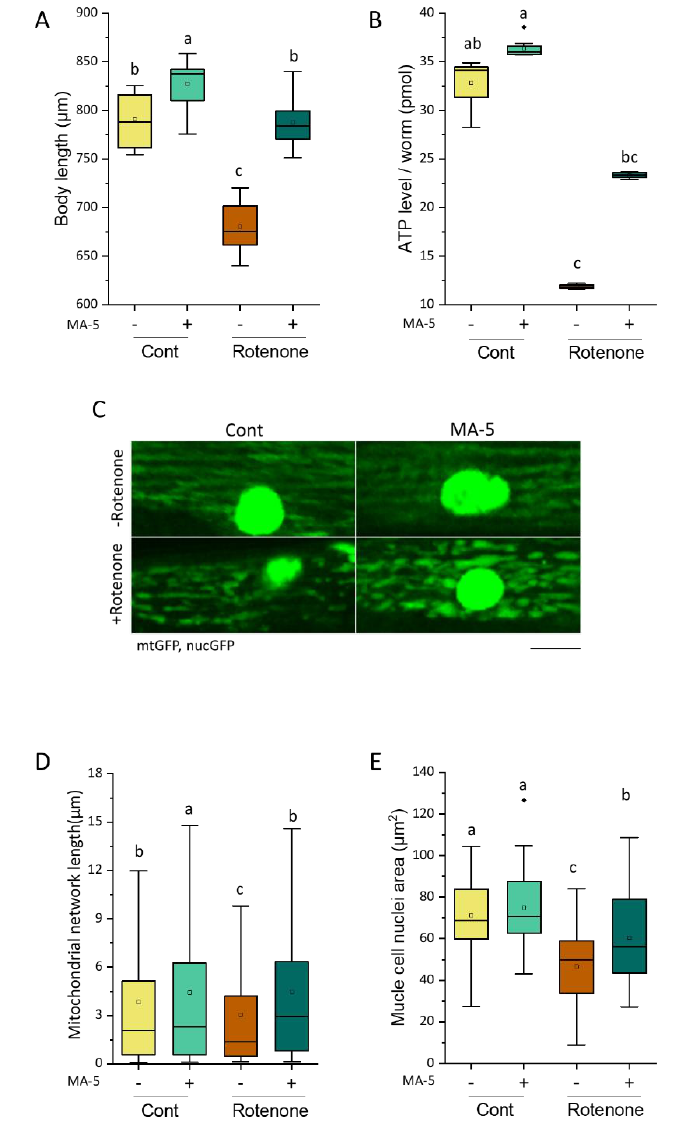
Figure 5. MA-5 suppressed rotenone-induced growth retardation, ATP level decline, mitochondrial fragmentation and nuclear breakdown. ( A ) The body length of N2 worms following rotenone treat- ment with or without MA-5 ( n = 11–20 worms/treatment) was monitored after 48 h. Different letters indicate significant differences ( p ≤ 0.05) by one-way ANOVA and Tukey’s HSD test. ( B ) ATP levels in N2 worms following rotenone treatment with or without MA-5 ( n = 12–18 worms/treatment) were monitored after 48 h. ATP levels were assessed using an ATP determination kit (Molecular Probes, Eugene, OR, USA). Different letters indicate significant differences ( p ≤ 0.05) using the Dunn’s test with all data points including outliers. ( C ) Representative images of mitochondrial and nuclear morphology after 48 h treatment (scale bar: 8 µ m). Synchronized SD1347 worms ( ccIs4251 [(pSAK2) myo-3p::GFP::LacZ::NLS+ (pSAK4) myo-3p::mitochondrial GFP + dpy-20(+) ]) I following rotenone treat- ment with or without MA-5 were monitored after 48 h. ( D ) The mitochondrial network length ( n ≥ 600 mitochondria from 5–8 worms/treatment) and ( E ) muscle cell nuclei area in SD1347 worms following rotenone treatment with or without MA-5 ( n ≥ 20 nuclei from 6–8 worms/treatment) were monitored after 48 h. Different letters indicate significant differences ( p ≤ 0.05) by one-way ANOVA and Tukey’s HSD test with all data points including outliers. Data are shown as box plots to indicate median (central line) and mean (square mark). Cont: control treated with 0.1% of DMSO; MA-5: 10 µ M; Rotenone: 2 µ M; Diamond mark: outlier